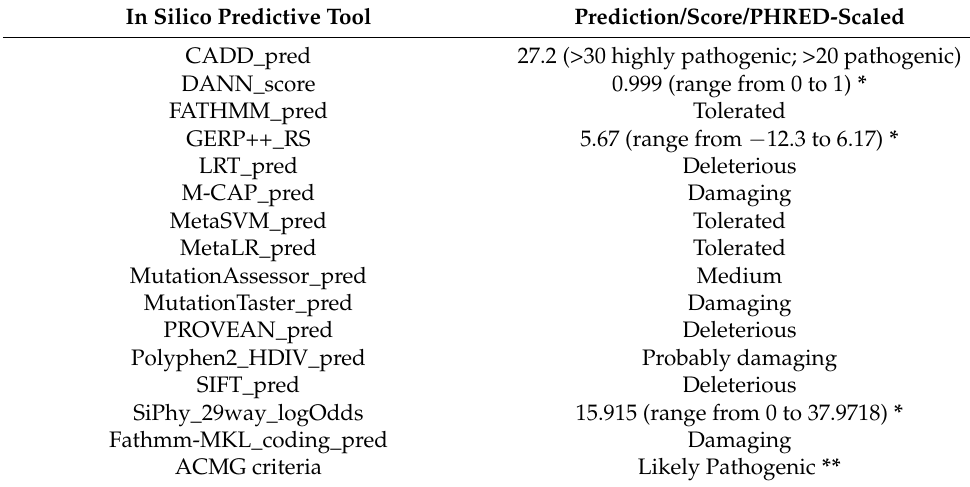
Table 3. Predictive test of the c.328A > G (p.Lys110Glu) new mutation.